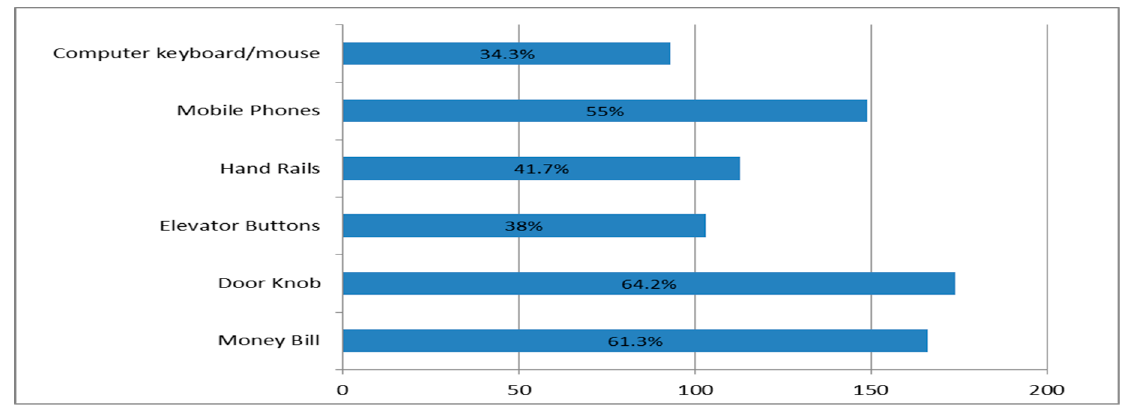
Figure 3. Participants views of sources of microbial contamination of the hands.